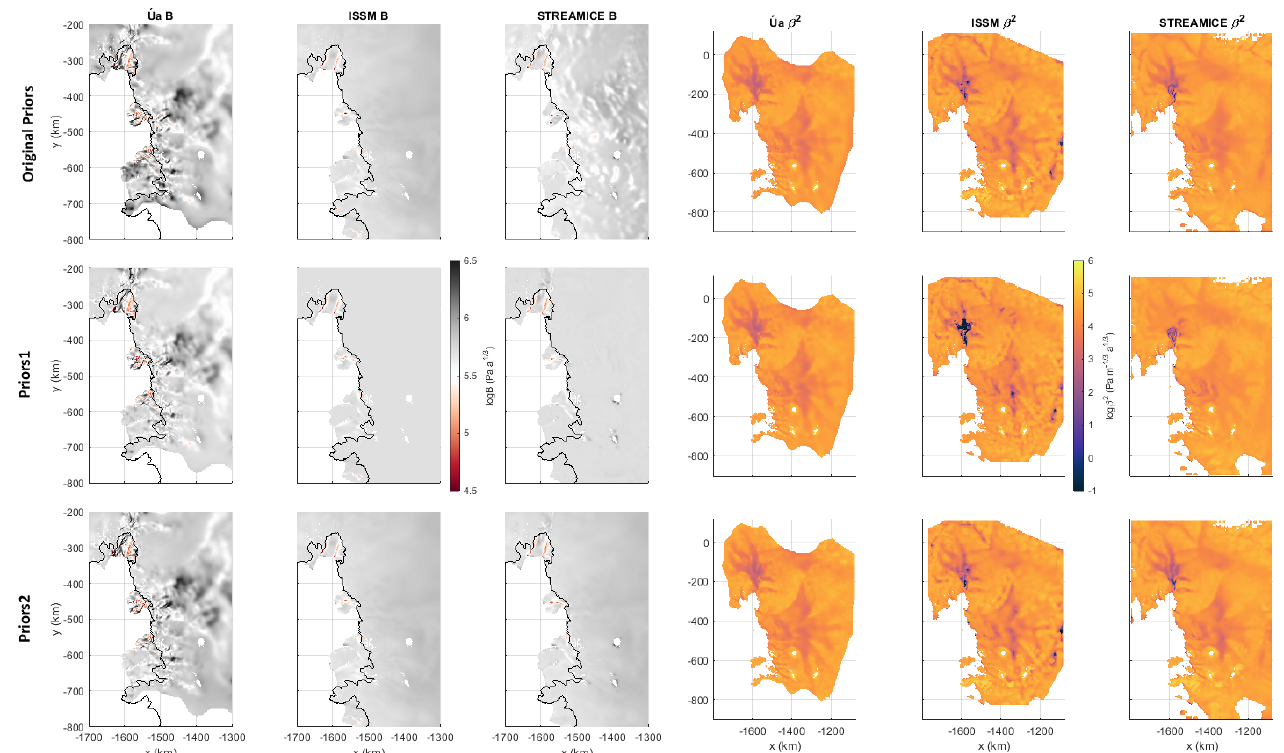
Figure B3. A comparison of the outputs of inversions using the original priors from each model in the first row and the two specified sets, Priors1 and Priors2, in the second and third